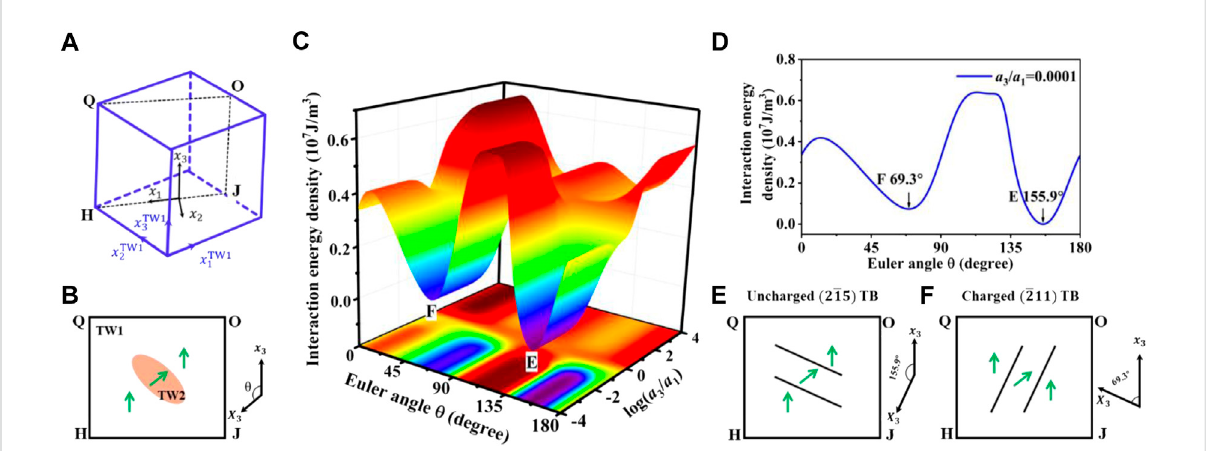
x TW 1 x TW 1 1 2 3 coordinate. Strain compatibility